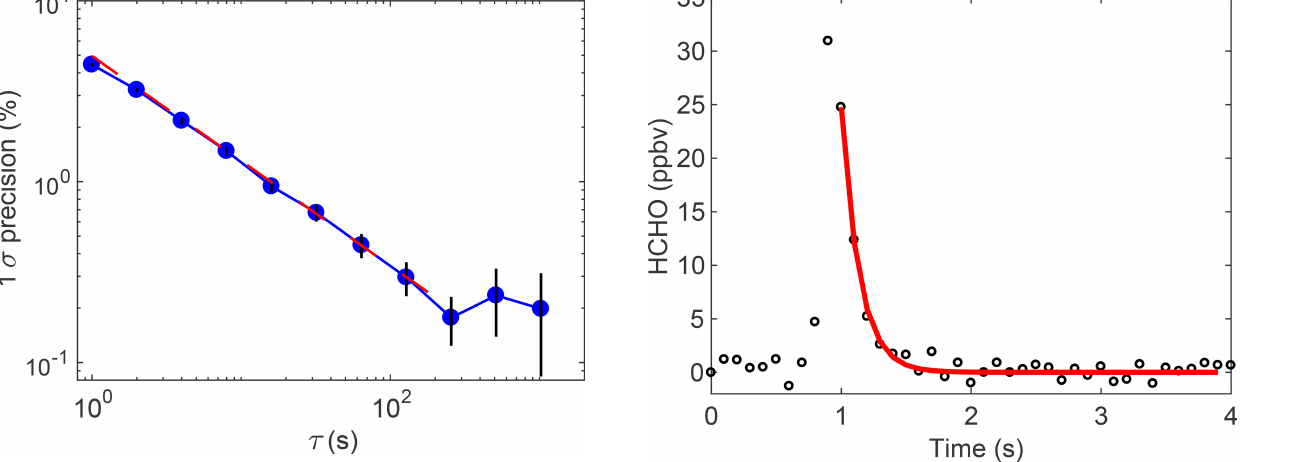
Figure 8. Pulses of HCHO were fit to provide the e -folding flush time (158 ± 10ms, 1 σ ) of the